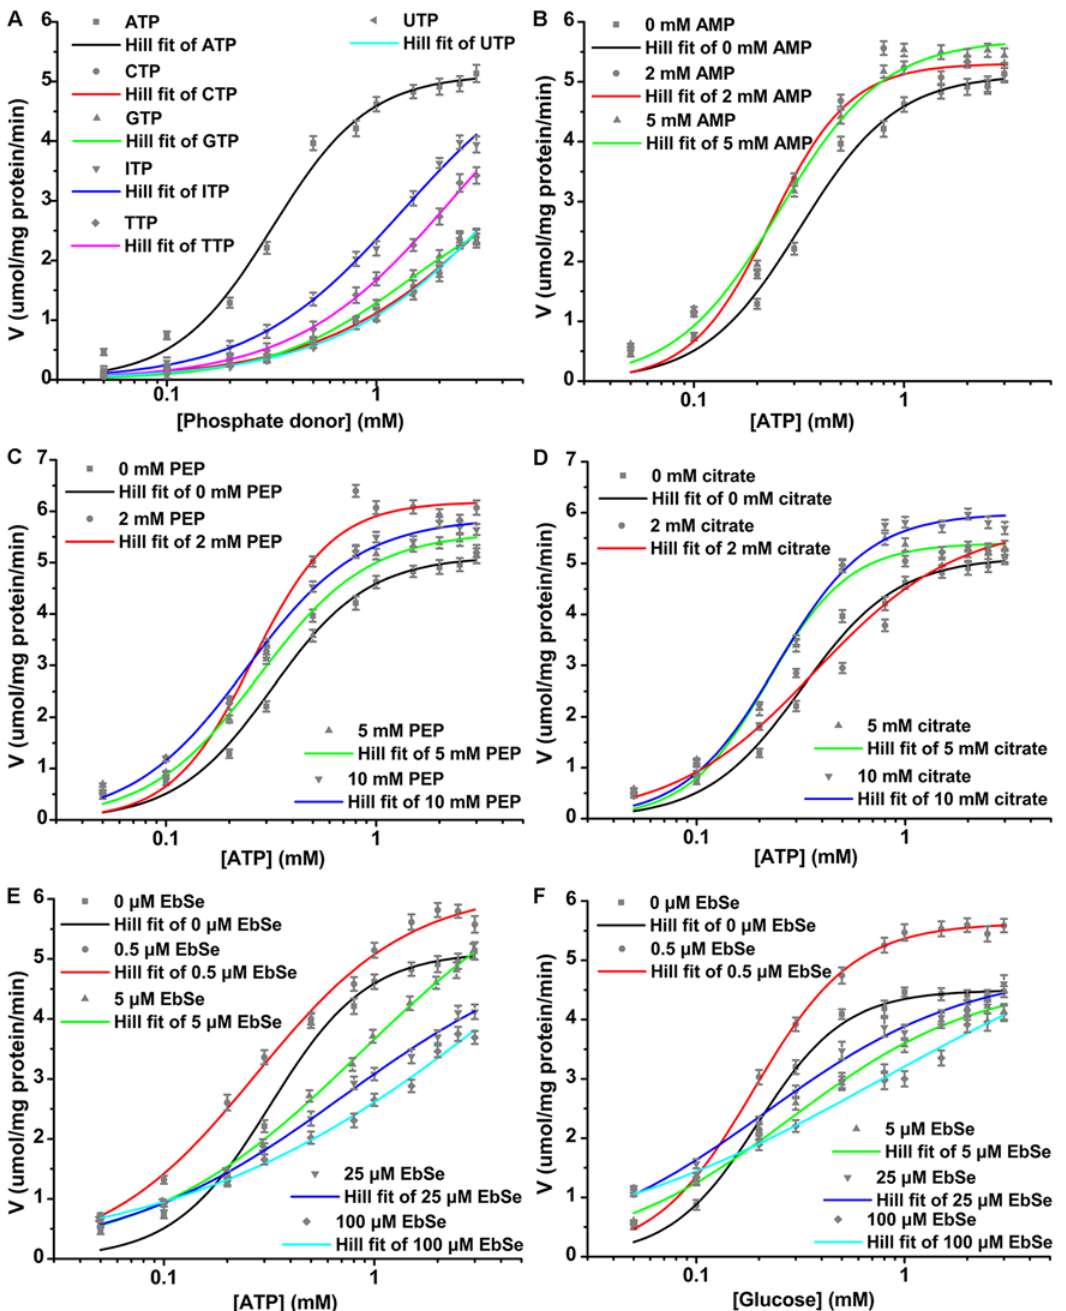
Fig 2. Effects of phosphate donors, effectors and EbSe on the enzyme kinetics of r Cs HK. The effect of 0~3 mM phosphate donors (ATP, CTP, GTP, ITP, TTP, and UTP) and fixed 3 mM glucose (A). The effect of 0~5 mM AMP (B), 0~10 mM PEP (C), 0~10 mM citrate (D), or 0~100 μ M EbSe (E) and fixed 3 mM glucose with respect to ATP. The effect of 0~100 μ M EbSe and fixed 3 mM ATP with respect to glucose (F).